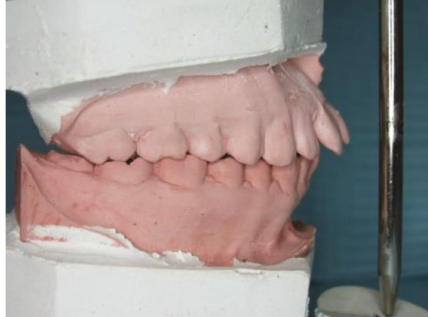
Figure 4: Case 1: study cast shows the large overjet of both central incisors.